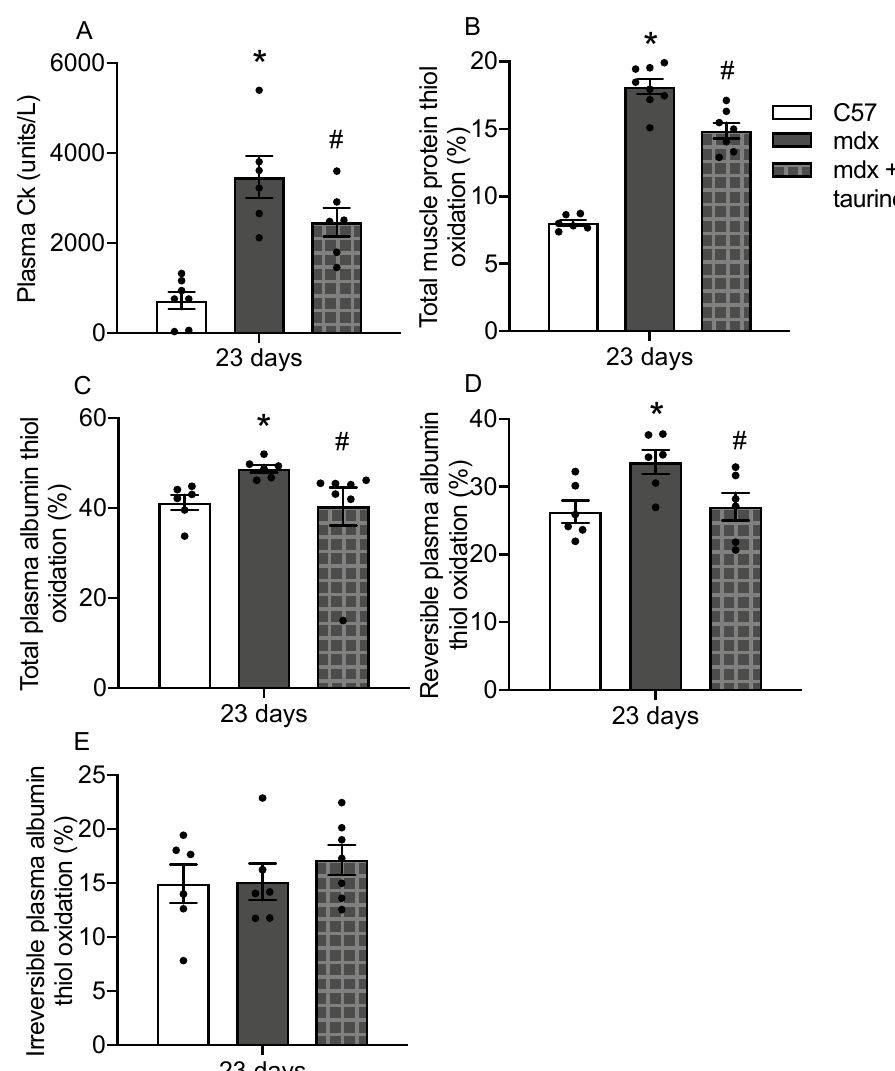
Figure 5. Plasma CK ( A ), total muscle protein thiol oxidation ( B ), total plasma albumin thiol oxidation ( C ), reversible plasma albumin thiol oxidation ( D ), irreversible plasma albumin thiol oxidation ( E ) and protein carbonylation ( D ) in C57 and mdx plasma at various time points. * = significantly ( p < 0.05) different to age matched control. # = significant ( p < 0.05) different to untreated mdx. Bars represent mean ± SEM and n = 5–8 per group.